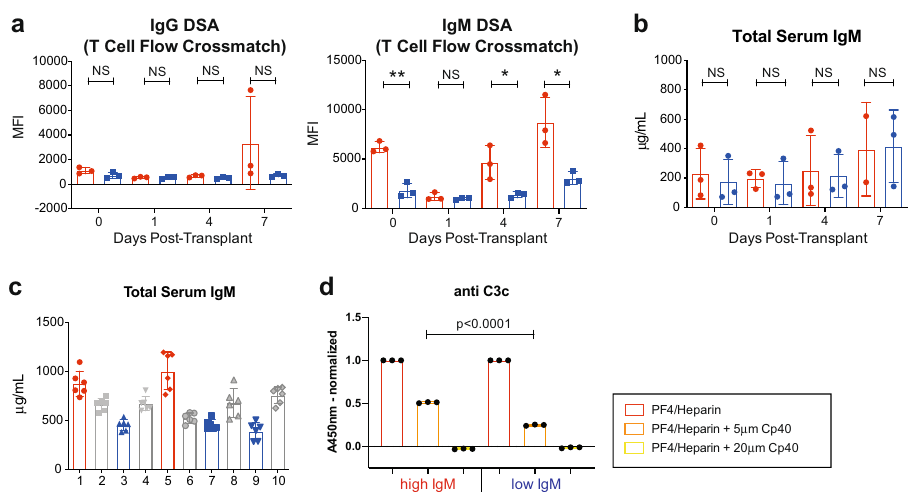
Fig. 6 IgM DSA is associated with treatment and early graft failure. a Early post-transplant donor-speci fi c antibody kinetics of IgG and IgM subclass in the early rejecter (ER, n = 3) and late rejecter group (LR, n = 3). IgM DSA levels were signi fi cantly higher in ER group at post-transplant day 0 ( p = 0.0012), 4 ( p = 0.0322), and 7 ( p = 0.0203) compared to LR group. N number indicates samples from biologically independent animals. b Total serum IgM levels during the fi rst week post-transplant (day 0 – 7) in the ER ( n = 3) and LR ( n = 3) groups. N number indicates samples from biologically independent animals. c Total serum IgM levels of n = 10 naive primates not included in this in vivo study. N number indicates samples from biologically independent animals with 6 replicates. d In vitro C3c assay comparing the Cp40 treatment effect in primates with high serum IgM levels (red; n = 3) and low serum IgM levels (blue; n = 3). N number indicates independent experiments. All Data are presented as mean ± SD; * p < 0.05; ** p < 0.01; *** p < 0.001 using two-tailed parametric unpaired t test; NS indicates no statistical signi fi